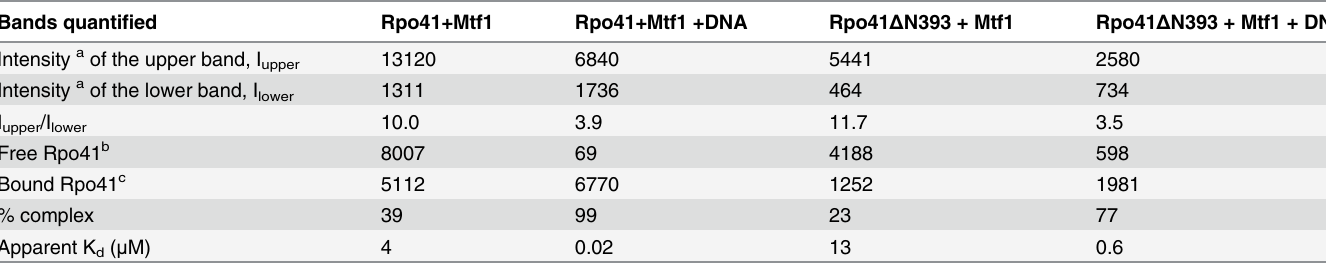
Table 1. Densitometry scanning of SDS with Mtf1 and Rpo41.